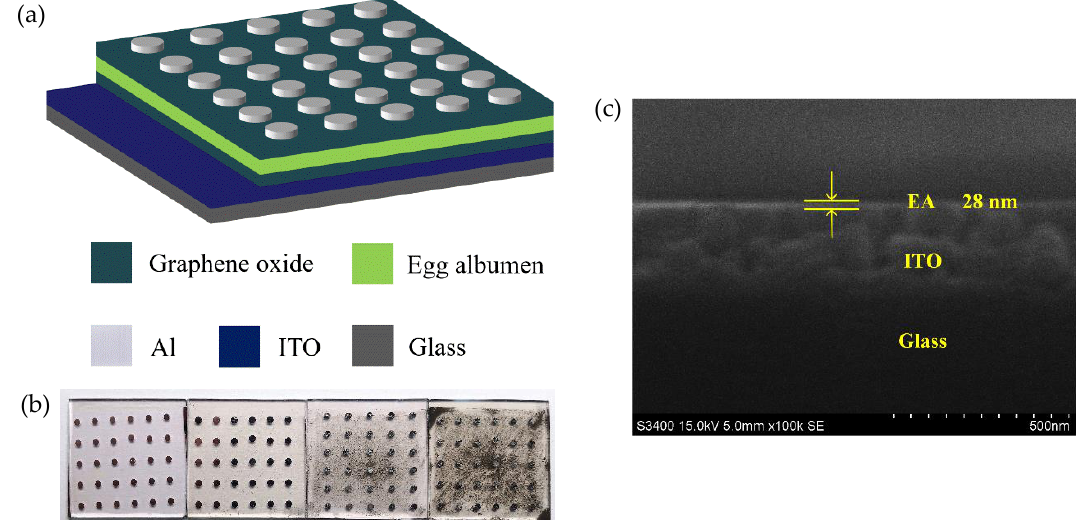
Figure 1. ( a ) ITO/GO/EA/GO/Al device structure. ( b ) Picture of ITO/EA/Al and ITO/GO/EA/GO/Al Figure 1. ( a ) ITO / GO / EA / GO / Al device structure. ( b ) Picture of ITO / EA / Al and ITO / GO / EA / GO / Al devices (from left to right are the ITO/EA/Al device and the ITO/GO/EA/GO/Al devices with GO devices (from left to right are the ITO / EA / Al device and the ITO / GO / EA / GO / Al devices with GO concentrations of 0.05 ωt%, 0.5 ωt%, and 2 ωt% in the GO layers). ( c ) SEM cross-sectional image of an concentrations of 0.05 ω t %, 0.5 ω t %, and 2 ω t % in the GO layers). ( c ) SEM cross-sectional image of EA film. an EA